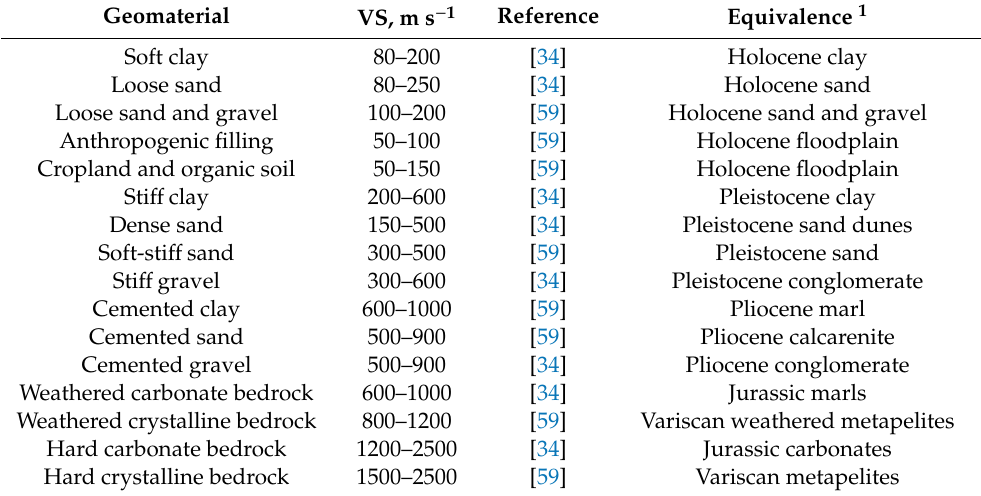
Table 4. Summary of some reference VS ranges compiled from the scientific literature for di ff erent sediments and rocks, and its equivalence to the geological materials described in the SAL